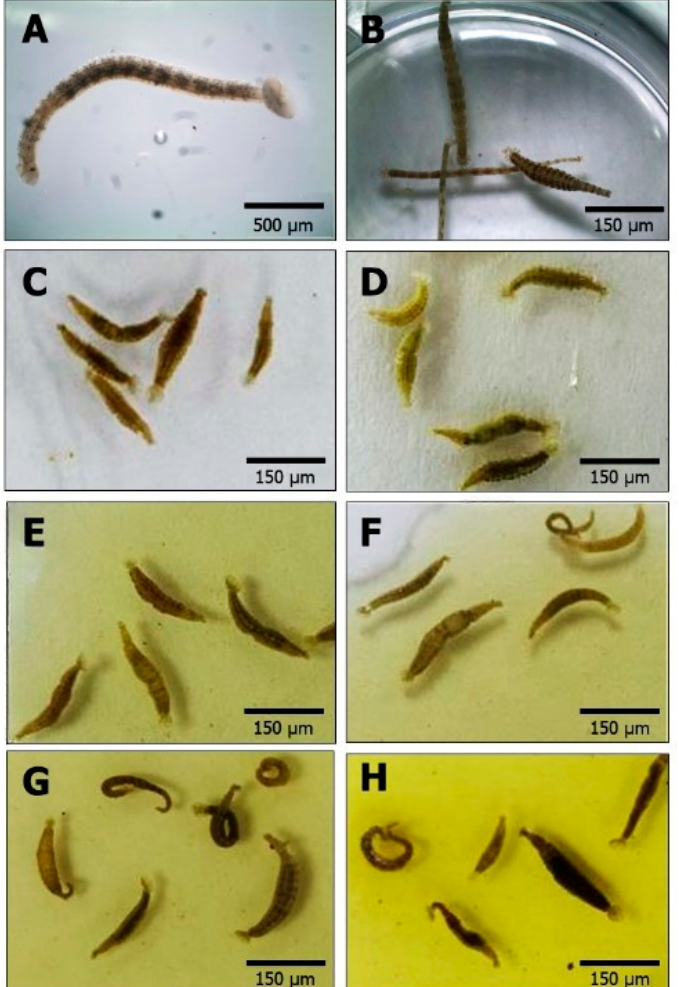
Figure 3. Experimental Zeylanicobdella arugamensis , ( A ) normal control, ( B ) positive control, ( C – G ) Sargassum polycystum methanol extract-administered group.